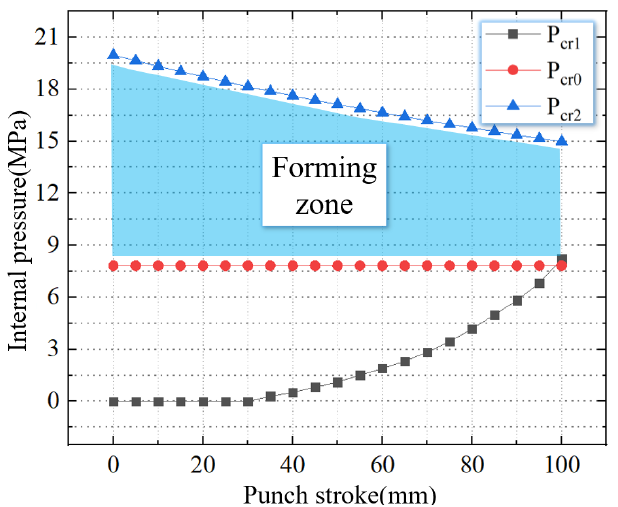
Figure 13. The forming zone of TUBG (thickness-diameter ratio = 1.67%).